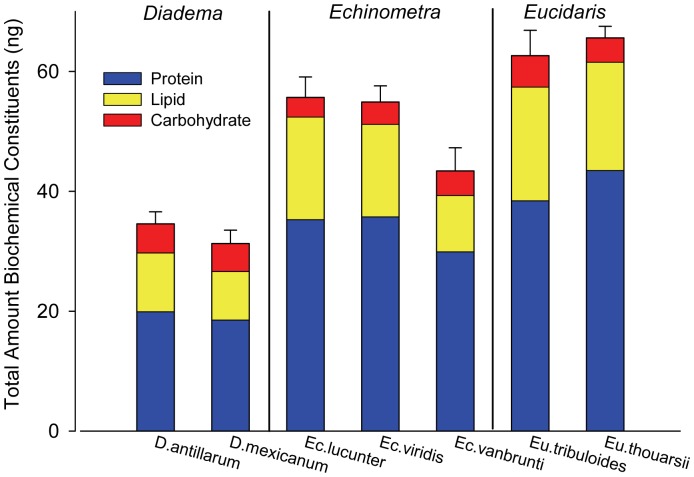
Mean biochemical constituent content of eggs.Average (±1 SE) summed total amounts (ng) of biochemical constituents per egg per species. Average protein (blue), lipid (yellow), and carbohydrate (red) content per egg per species are indicated.